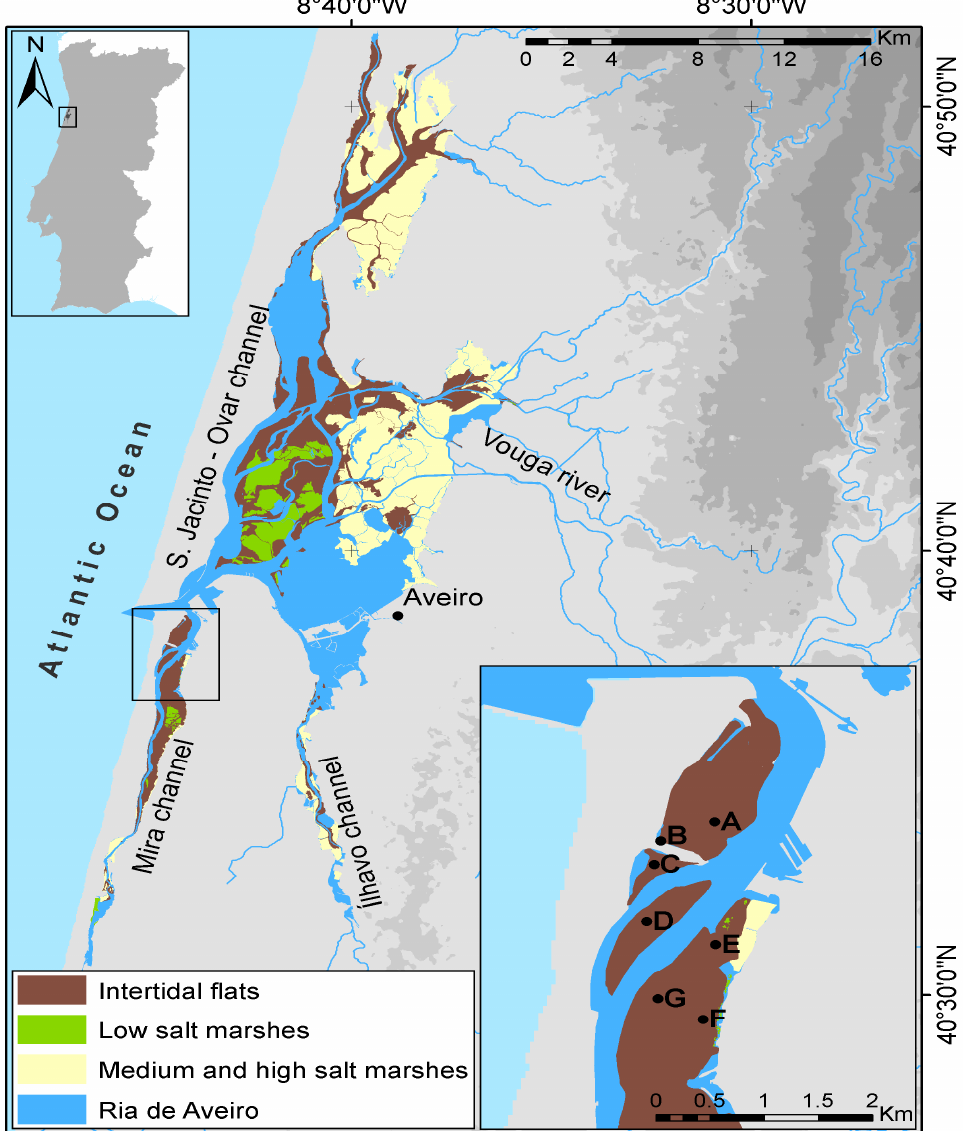
Figure 8. The Ria de Aveiro coastal lagoon, main channels and primary habitats (habitats shapefiles provided by AMBIECO/PLRA [43]). Map generated with ArcGIS 10.2 Software (Esri, Redlands, CA, USA) (http://www.esri.com/software/arcgis/arcgis-for-desktop). Credits of World Terrain Base: USGS—Land Processes Distributed Active Archive Center; Direção Geral do Território; Portuguese Environmental Agency (APA) and updated AMBIECO/PLRA habitats shape-file.